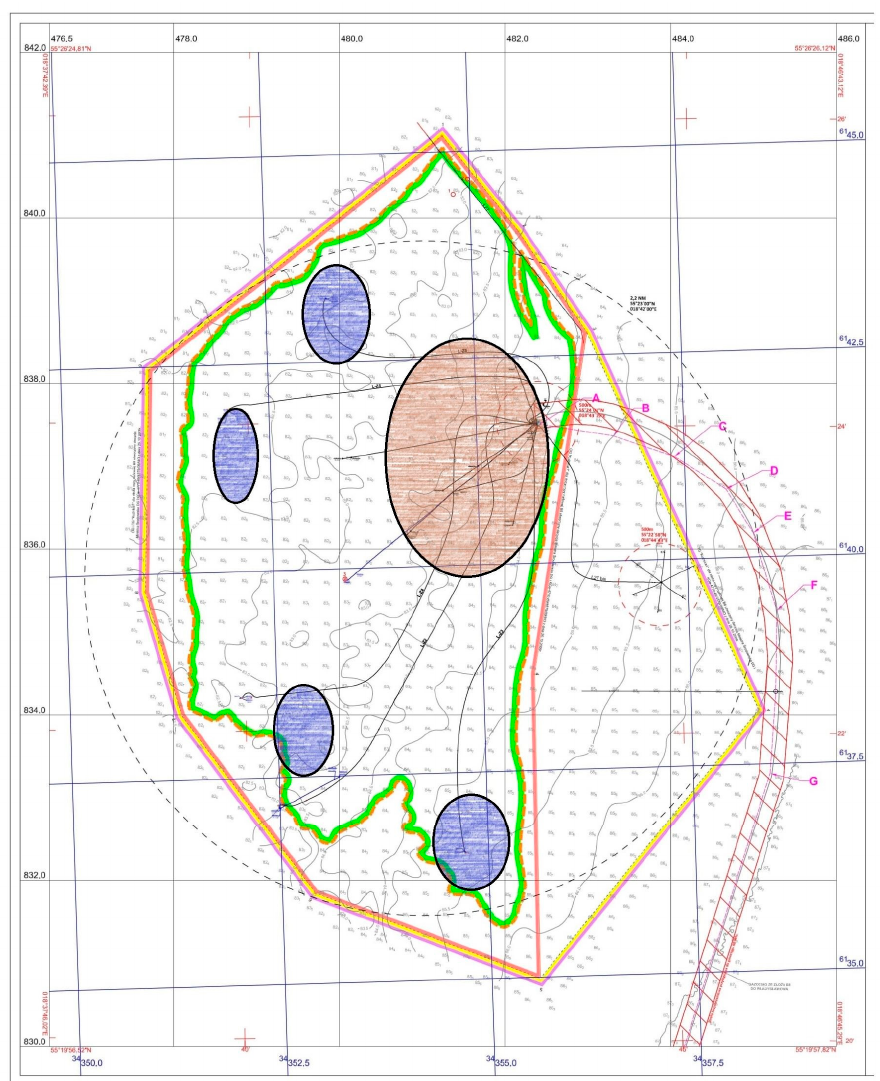
Figure 2. B8 oilfield map; brown areas indicate production zone, while blue areas are injection zones. Water is injected into the aquifer, creating a circular shape around the production area.